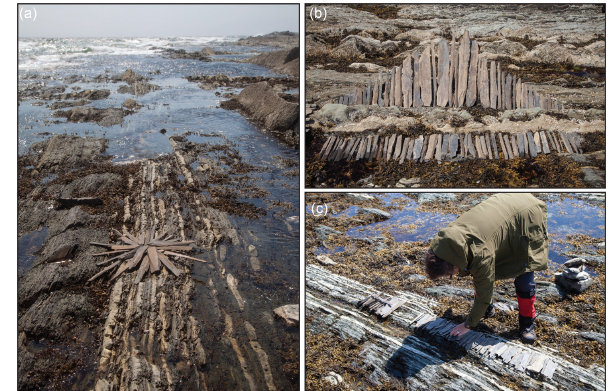
Figure 7. (a–b) Examples of pencil slate sculptures built on the Cambrian–Ordovician boundary after the main Boundary | Time | Surface installation. (c) Construction of sculptures; artist for